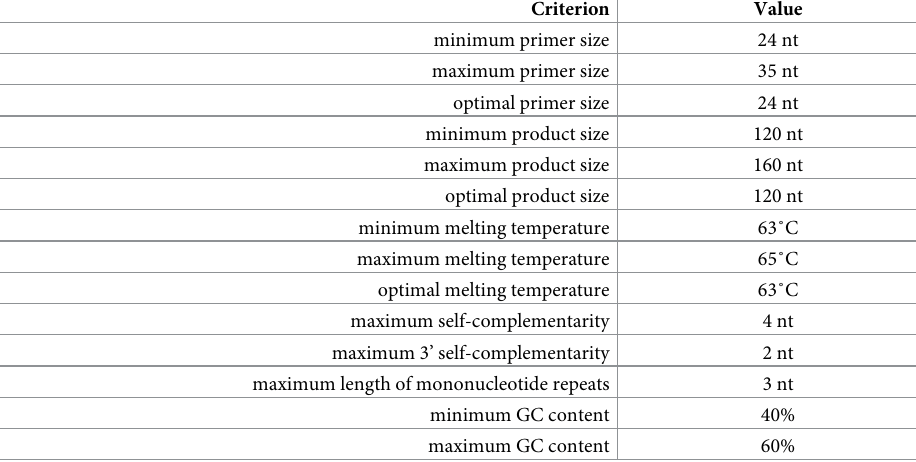
Table 1. Primer selection criteria specified in